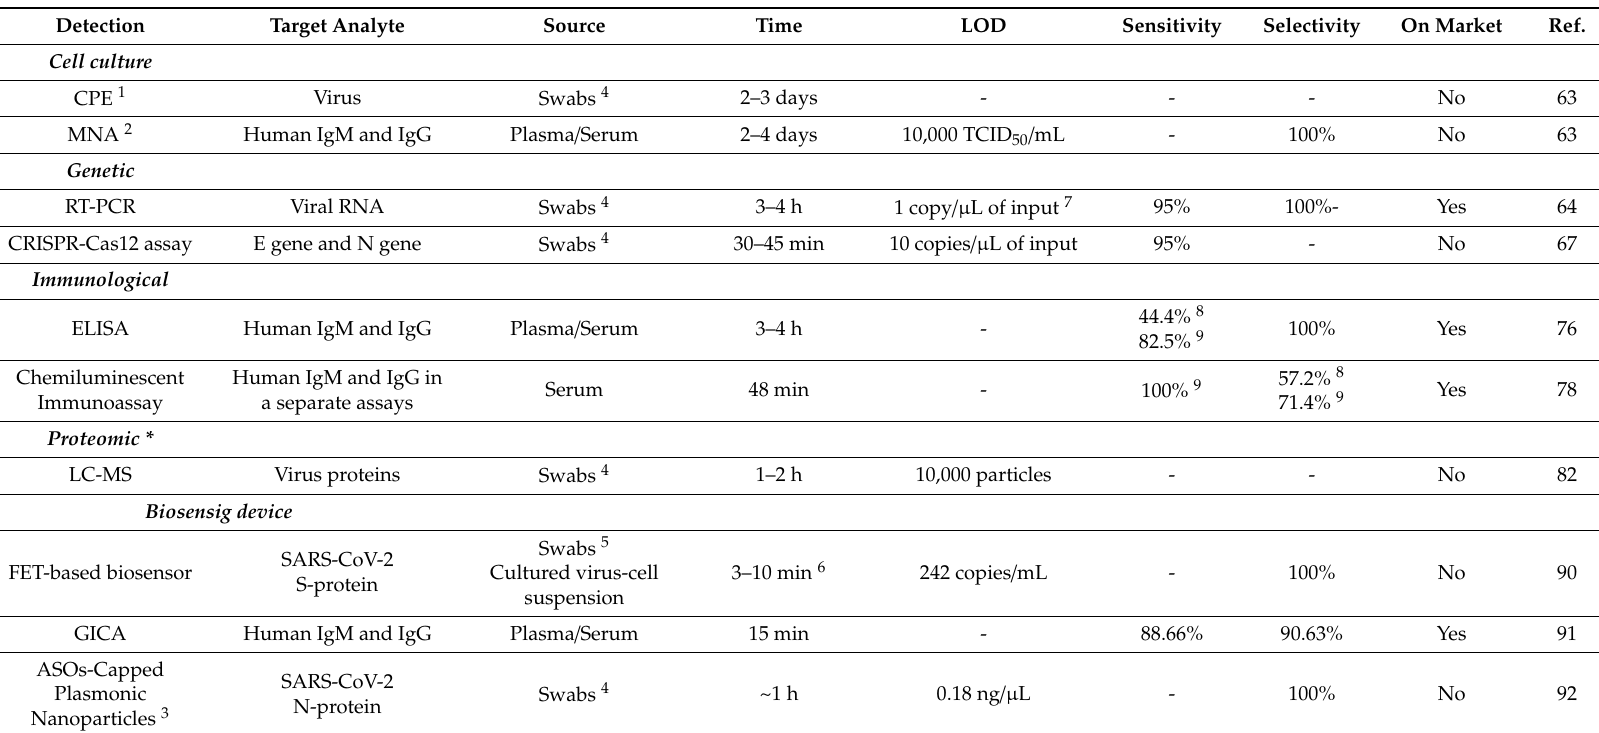
Table 1. Monitoring and detection methodologies for